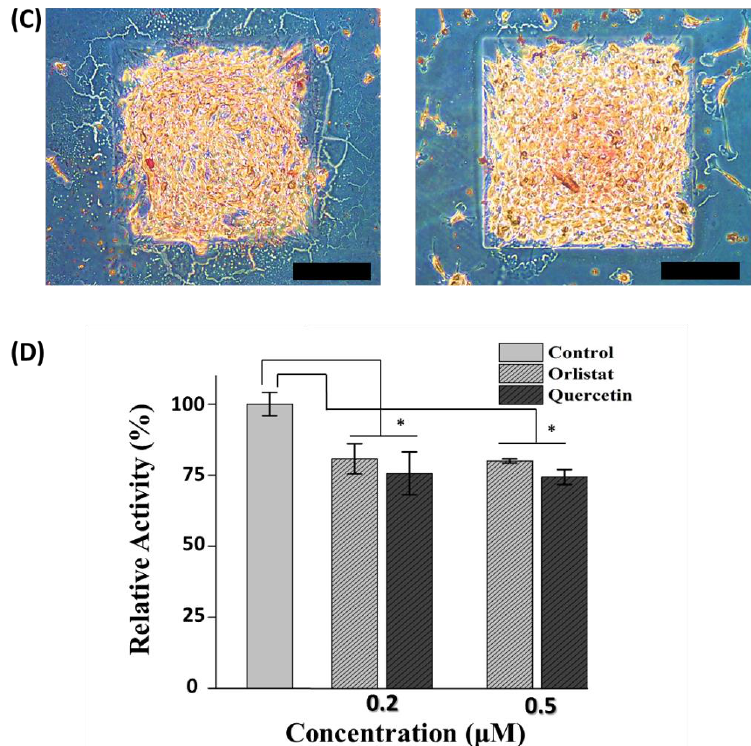
Figure 4. Chemical structure of ( A ) orlistat and ( B ) quercetin. ( C ) Optical images of 3T3-L1 cells were cultured for six days with anti-obesity agents stained with Oil Red O. ( D ) 3T3-L1 cell differentiation anti-obesity activity from orlistat and quercetin. Scale bar indicates 200 μ m. Results were analyzed by a one-way analysis of variance (ANOVA) test (* p < 0.001 control vs., orlistat and quercetin group).